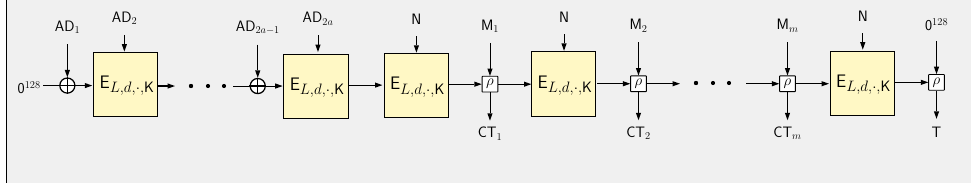
Figure 11: The high-level view of Romulus-N1 , which depicts the processing of 2 a associated data and m message blocks. L denotes the 56-bit LFSR that counts the number of processed blocks, and d denotes a single byte domain separator followed by 0 64